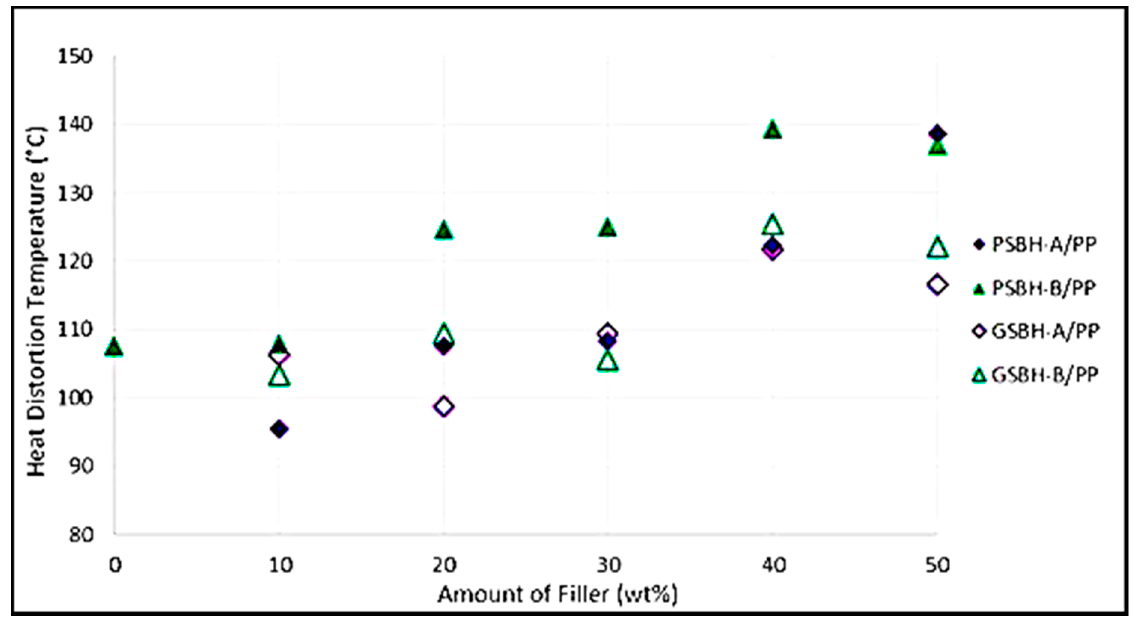
Figure 11. Heat distortion temperature of PP/PSBH composites.